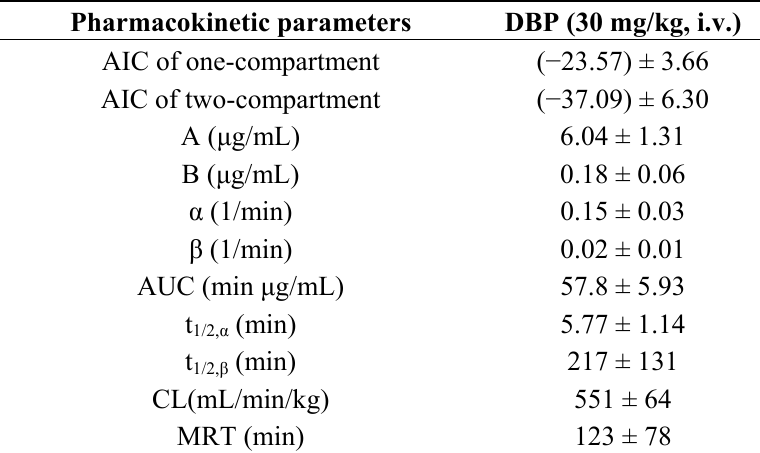
Table 4. Pharmacokinetic parameters of DBP in rat plasma after DBP (30 mg/kg, i.v.)